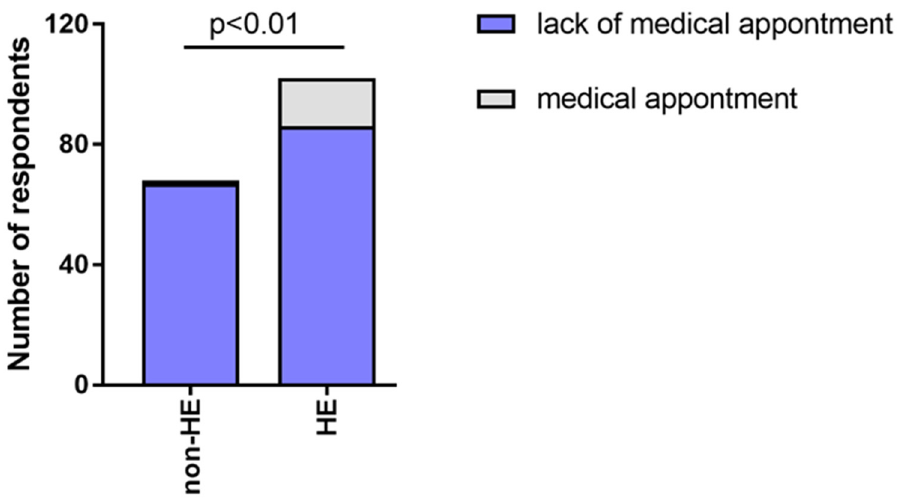
Figure 13. The frequency of medical appointment during pandemic in both groups (HE-study group and